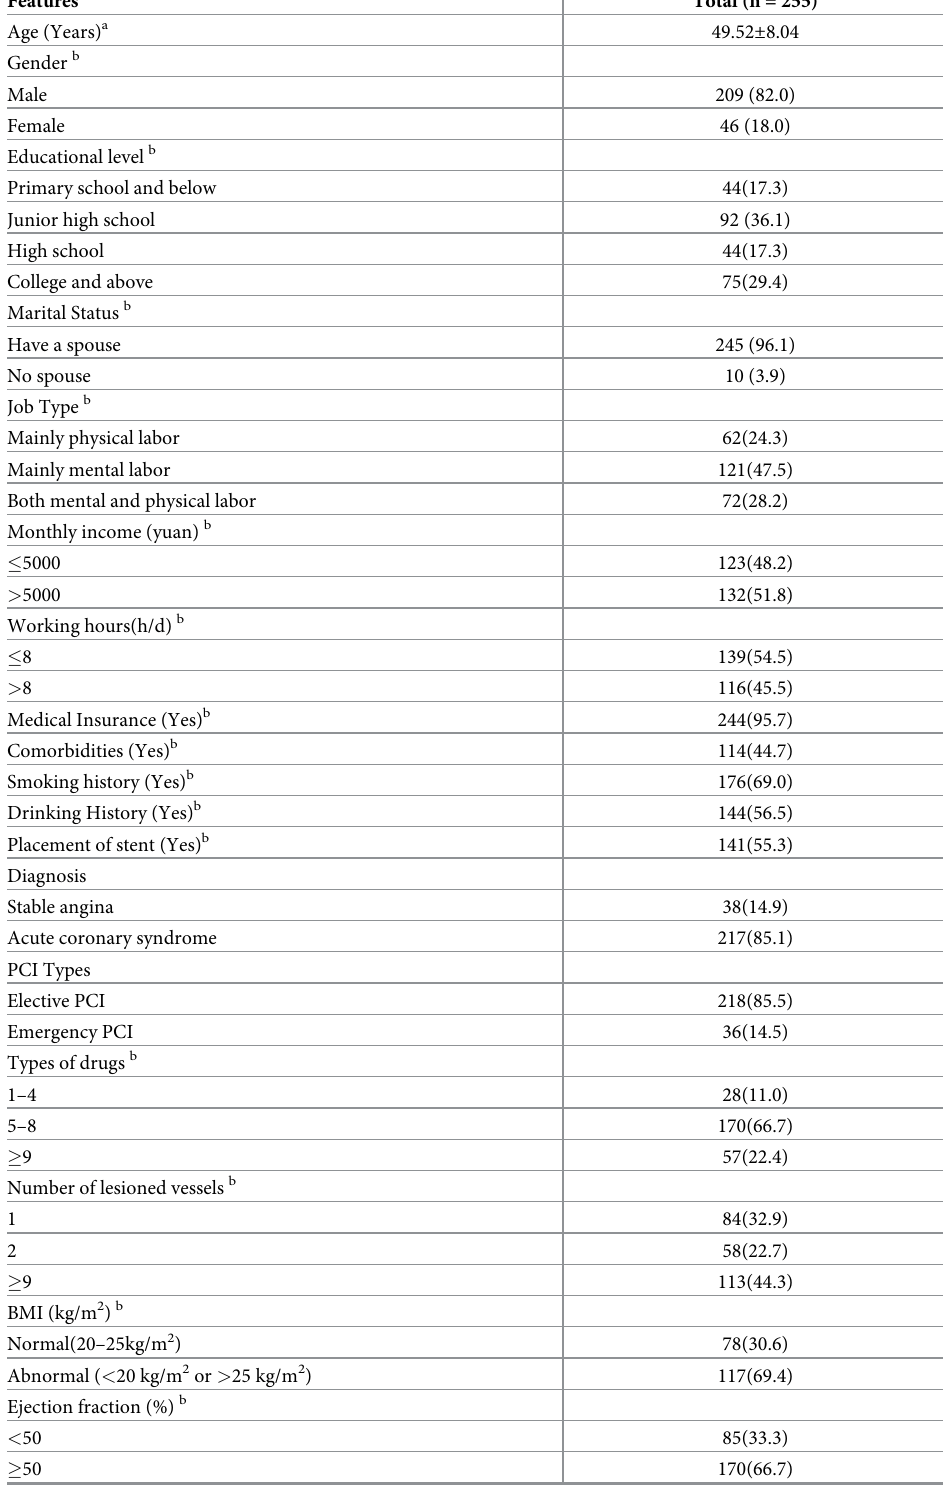
Table 1. 255 patients’ demographic and clinical